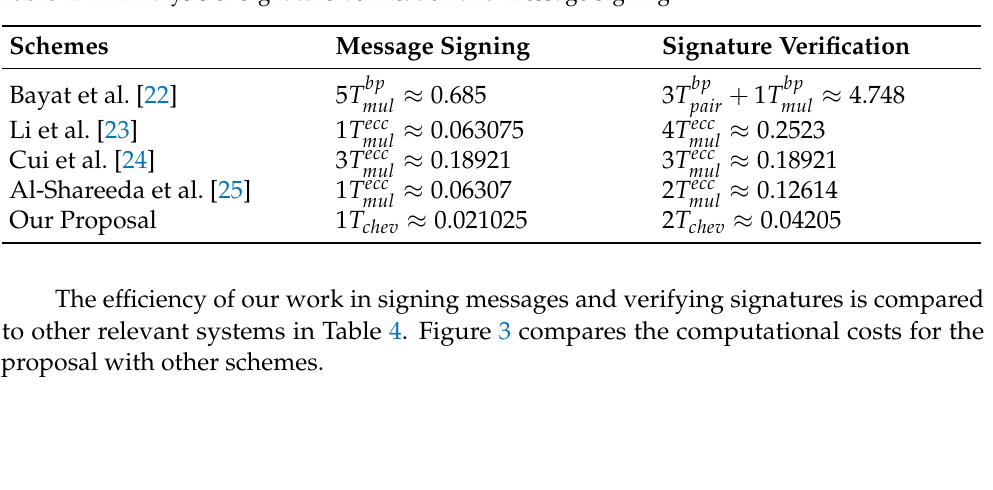
Table 4. An Analysis of Signature Verification and Message